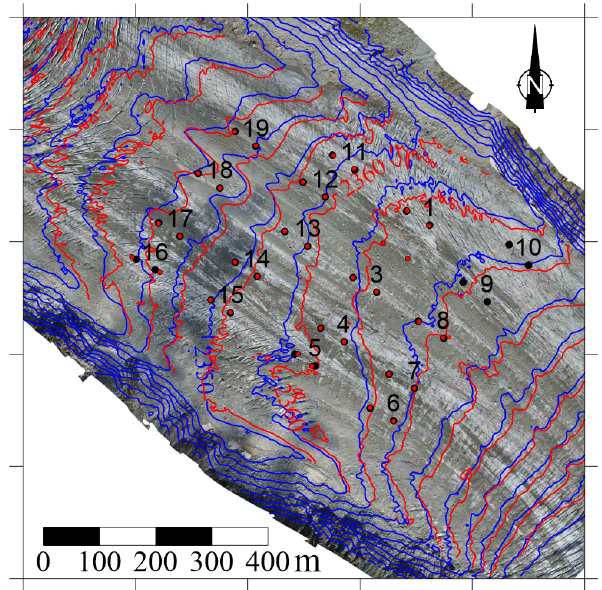
Figure 10. DEMs obtained from the UAV survey in 2018 (blue con- tour lines) and 2019 (red contour lines). The black dots correspond to the positions of the stakes in 2018 and 2019 observed from GNSS measurements. The red dots correspond to the ends of the horizontal velocity vectors obtained from UAV